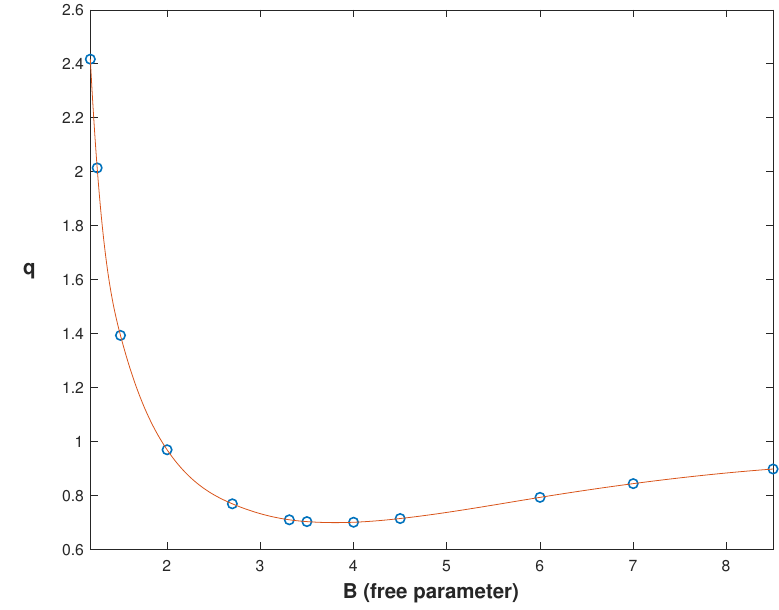
= h ( r ) ; note that h ( 0 ) = h ( ∞ ) = 1. g rr